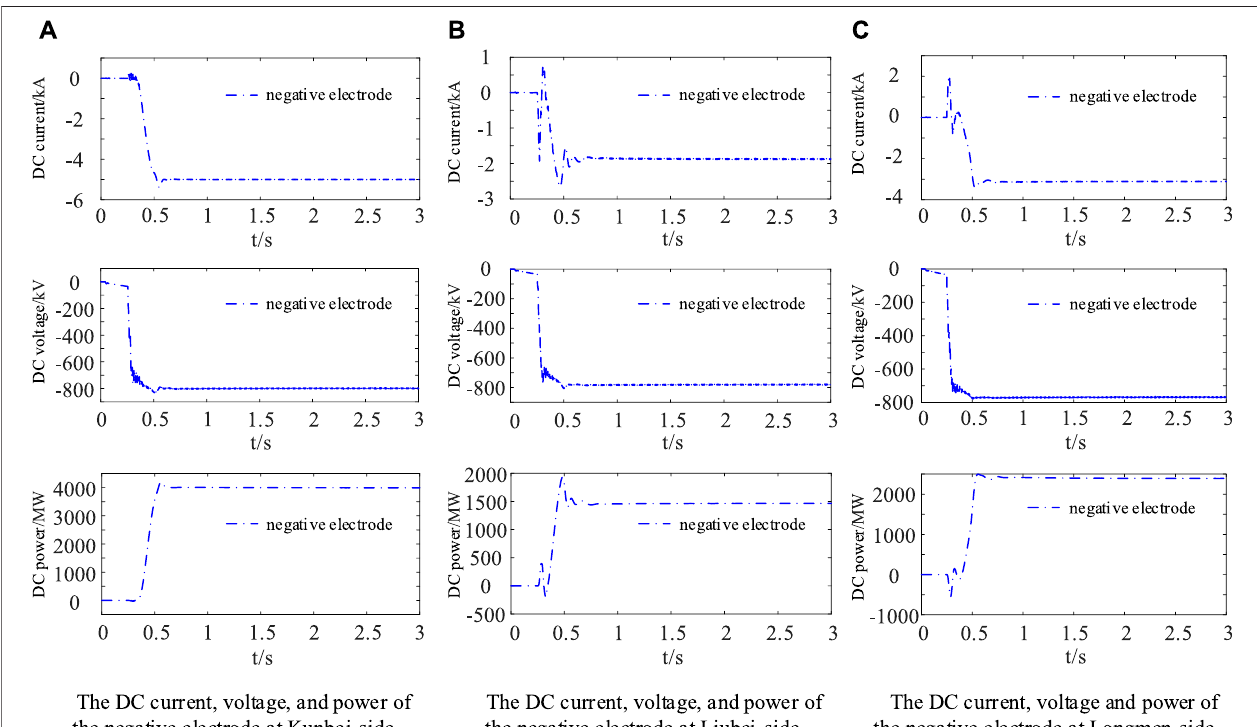
FIGURE 10 | Simulated waveform of negative full voltage ground return